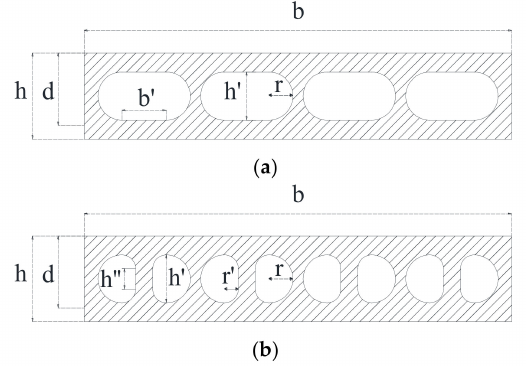
Figure 13. Types of cross-sections in donut-type voided slabs: ( a ) minimum cross-section; ( b ) donut cross-section. Table 7. Test